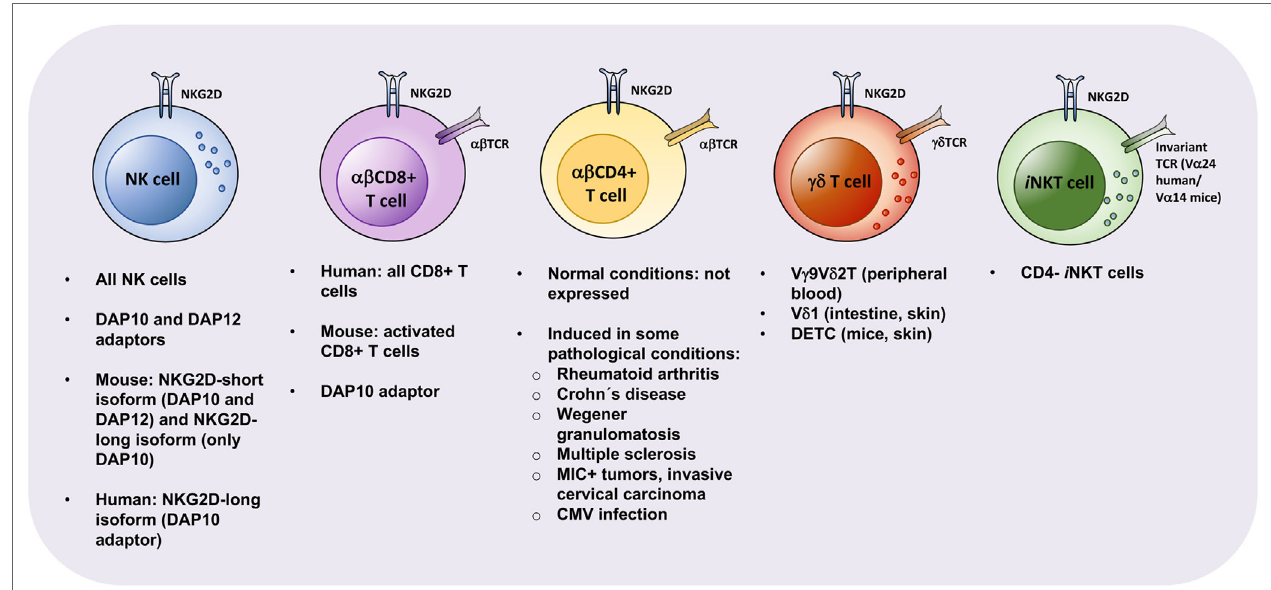
FiGURe 2 | Properties of natural killer group 2, member D (NKG2D)-expressing lymphocytes. NKG2D can be expressed by natural killer (NK) cells, αβ CD8 + T cells, γδ T cells, invariant NKT ( i NKT) cells, and αβ CD4 + T cells. However, its expression, alternative splicing, and coupling to adapter molecules vary between the indicated lymphoid subsets. Expression of NKG2D on certain lymphocytes correlates with activation (mouse αβ CD8 + T cells) or can be detected only in disease settings ( αβ CD4 + T cells). While NK cells, i NKT cells and CD8 + T cells are circulatory and can be detected in peripheral blood, other lymphoid cells, such as helper innate lymphoid cells (data not shown) and certain γδ T cells, are tissue-resident and are involved in local tissue immune responses. Similarly, pathologic αβ CD4 + T cells are enriched in affected tissues in depicted autoimmune conditions. Abbreviations: DETCs, dendritic epidermal T cells; CMV,